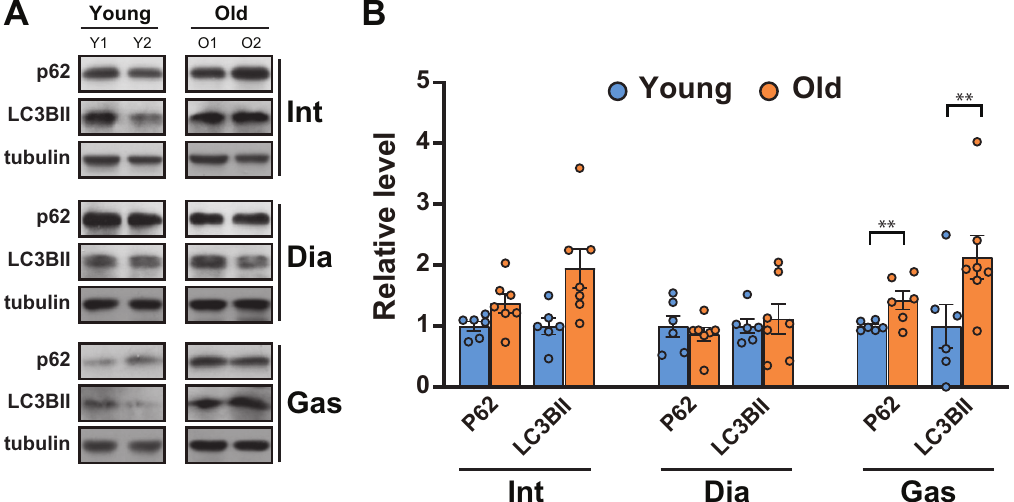
Figure 3. Autophagic flux was blocked in the gastrocnemii of aged rats. ( A ) The intercostal, diaphragm, and gastrocnemius muscles were lysed and subjected to Western blot analysis ( n = 6). ( B ) The relative intensities of the bands were quantified using ImageJ analysis software ( n = 6). Data for LC3BII and p62 were compared to levels of tubulin. The data are shown as the mean ± standard deviation.